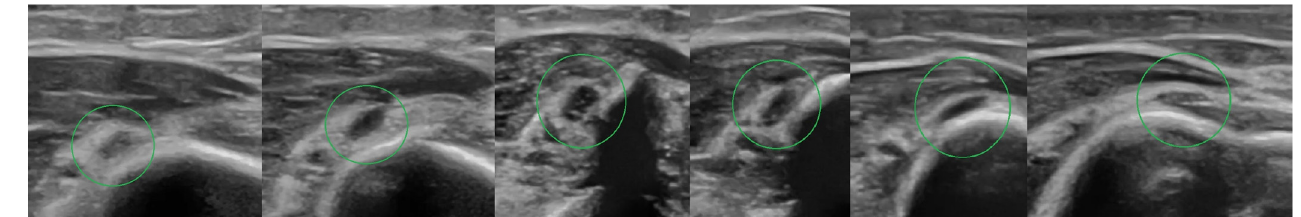
Figure 3. Ultrasound scan showing correct transverse section of radial nerve (the nerve and hy- perechogenic outline of the humeral shaft are marked).